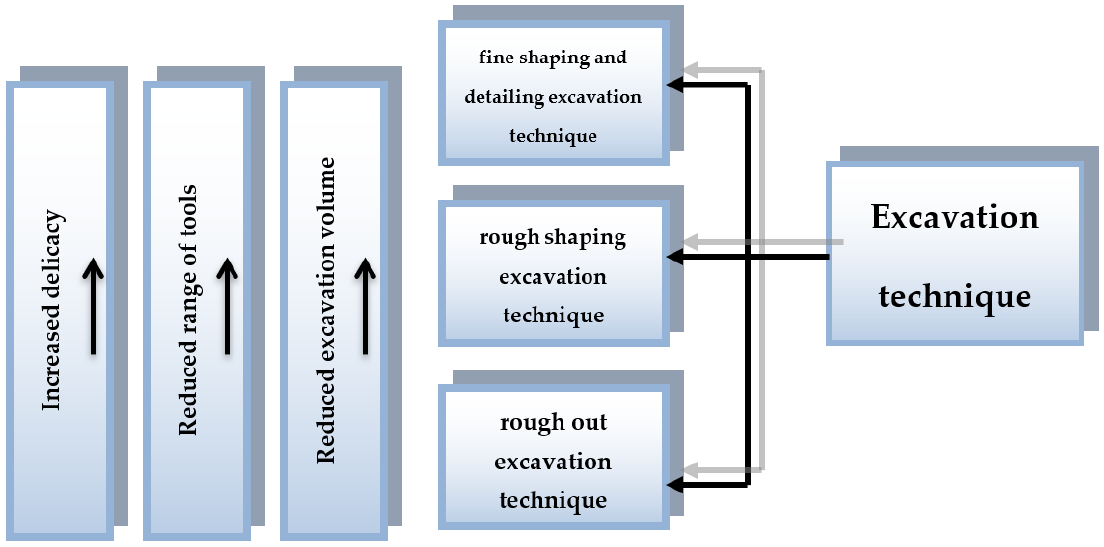
Figure 16. The impact of excavation technique on volume, delicacy and tools.